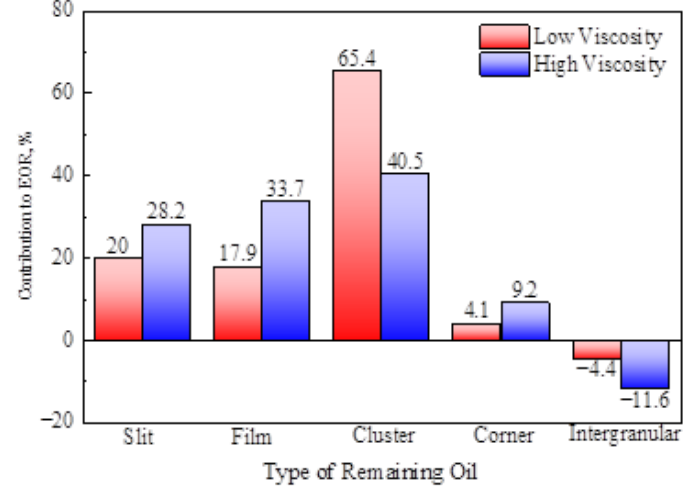
Figure 11. Contribution of different types of residual oil to enhanced oil recovery.